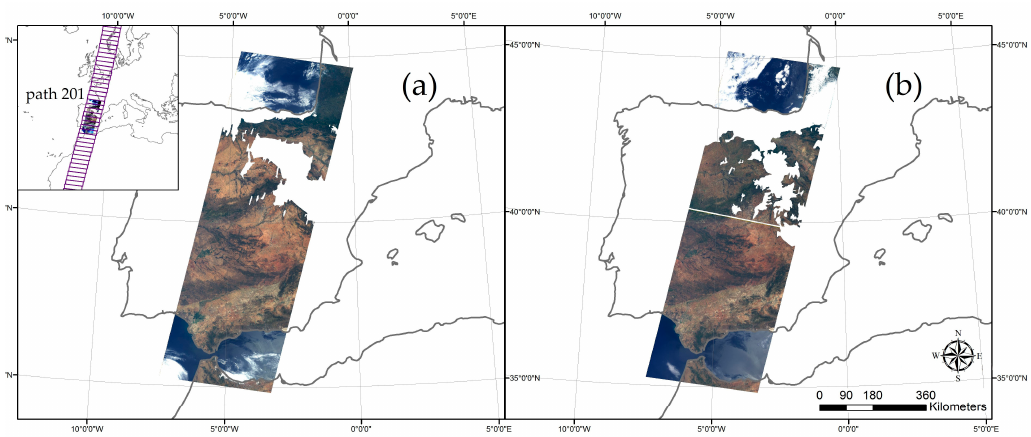
Figure 1. MISR orbits used in this study after cloud masking. ( a ) Represents orbit 29476, belonging to path 201 and captured on 3 July 2005; ( b ) Represents orbit 45320, belonging to path 201 and captured on 25 July 2008.